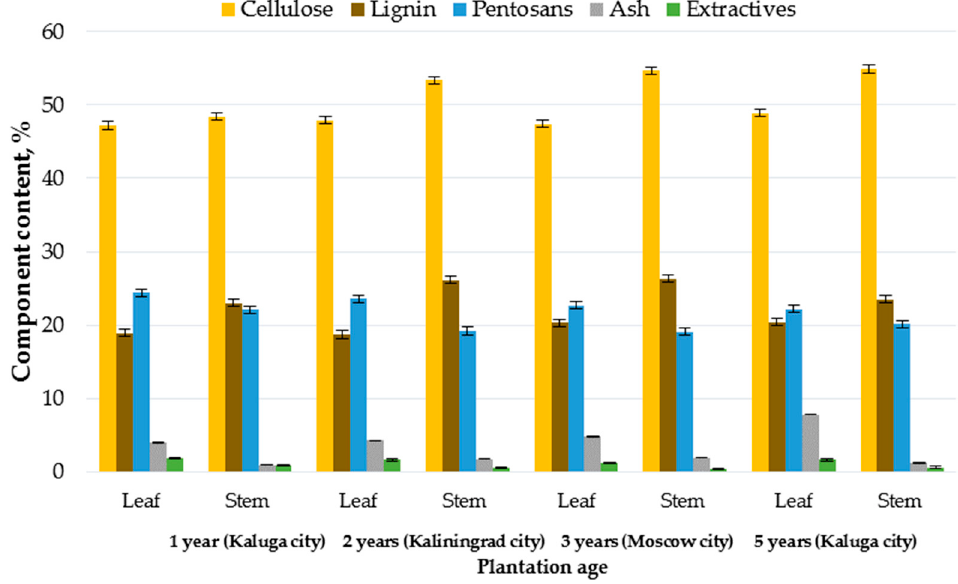
Figure 1. The chemical composition of the leaf and stem of Miscanthus × giganteus raised in Kaluga (plantation aged 1 year), Kaliningrad (plantation aged 2 years), Moscow (plantation aged 3 years) and Kaluga (plantation aged 5 years).